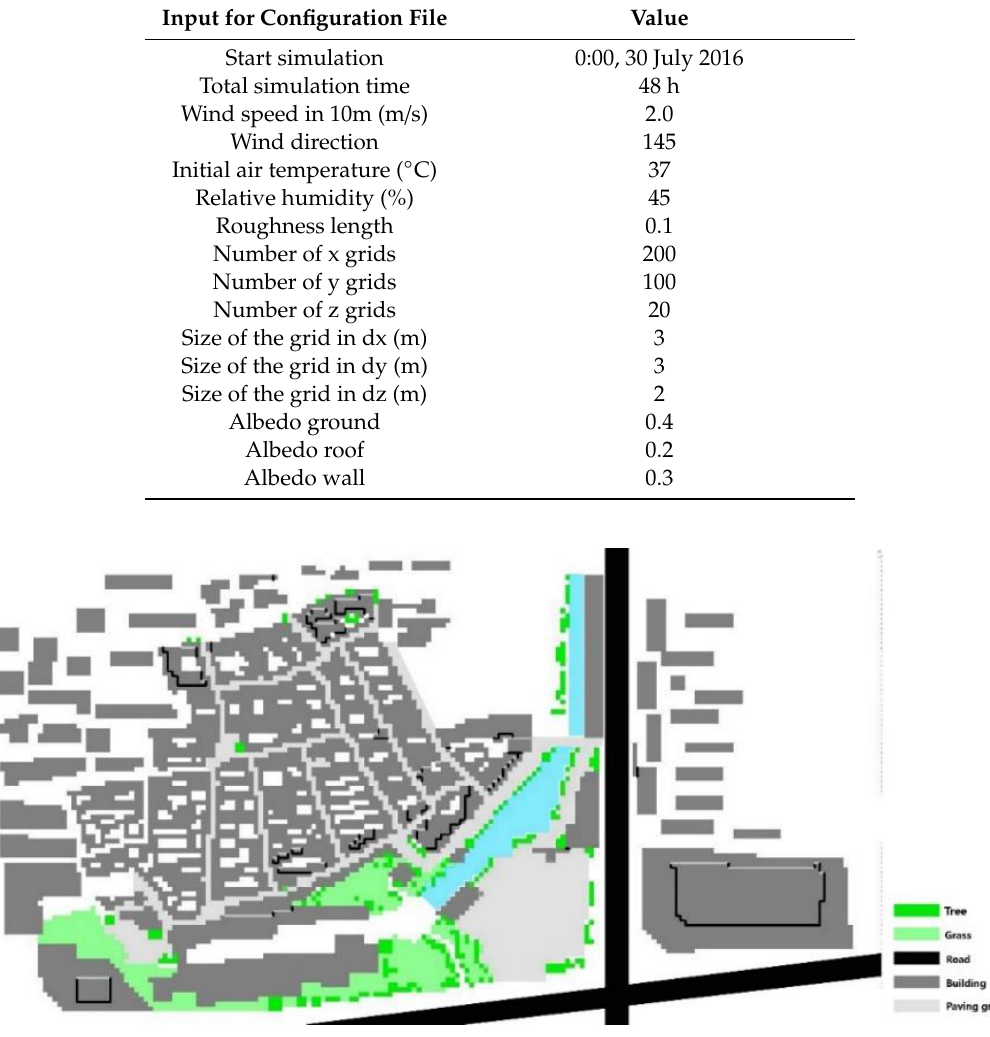
Figure 8. The simulated model in ENVI-met.